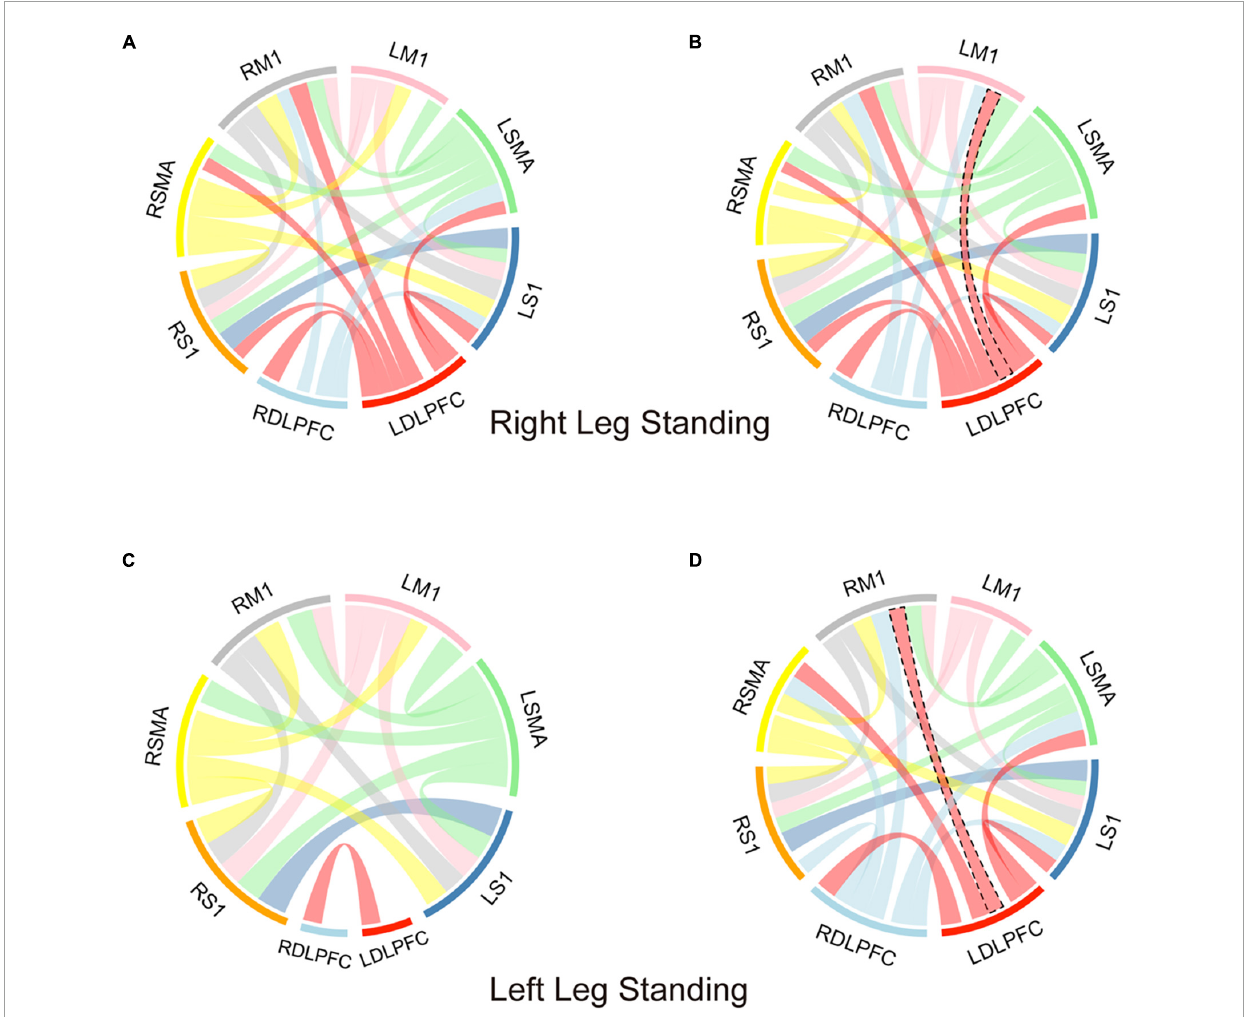
FIGURE4 The correlation analysis of each ROIs in the single-leg standing tasks. (A,B) The correlation analysis of each ROIs before (A) and after (B) iTBS in the right-leg standing tasks. (C,D) The correlation analysis of each ROIs before (C) and after (D) iTBS in the left-leg standing tasks. DLPFC, dorsolateral prefrontal cortex; M1, primary motor cortex; SMA, supplementary motor area; S1, Primary somatosensory cortex. The connection band between the two ROIs indicates the correlation of the two ROIs was significant. The width of the joining band indicates the size of correlation coefficient. The black dotted line indicates the correlation difference before and after the iTBS.